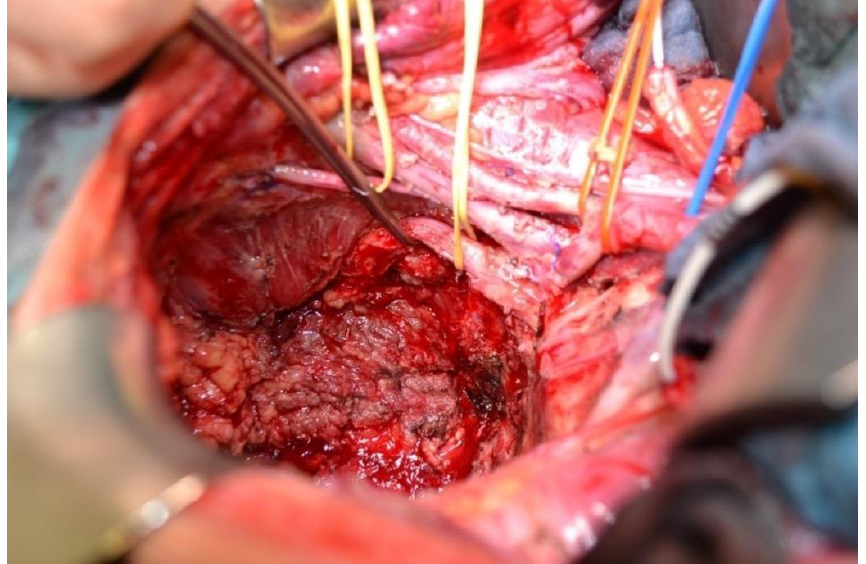
Figure 1. Intraoperative situs of a pelvic exenteration with resection of the ischiadic plexus with preservation of S1 and S2, as well as the obturator nerve (2 × yellow reins on the right) and place- ment of the internal vessels (red reins on the left) for rectal cancer recurrence (surgeon: J. Weitz).